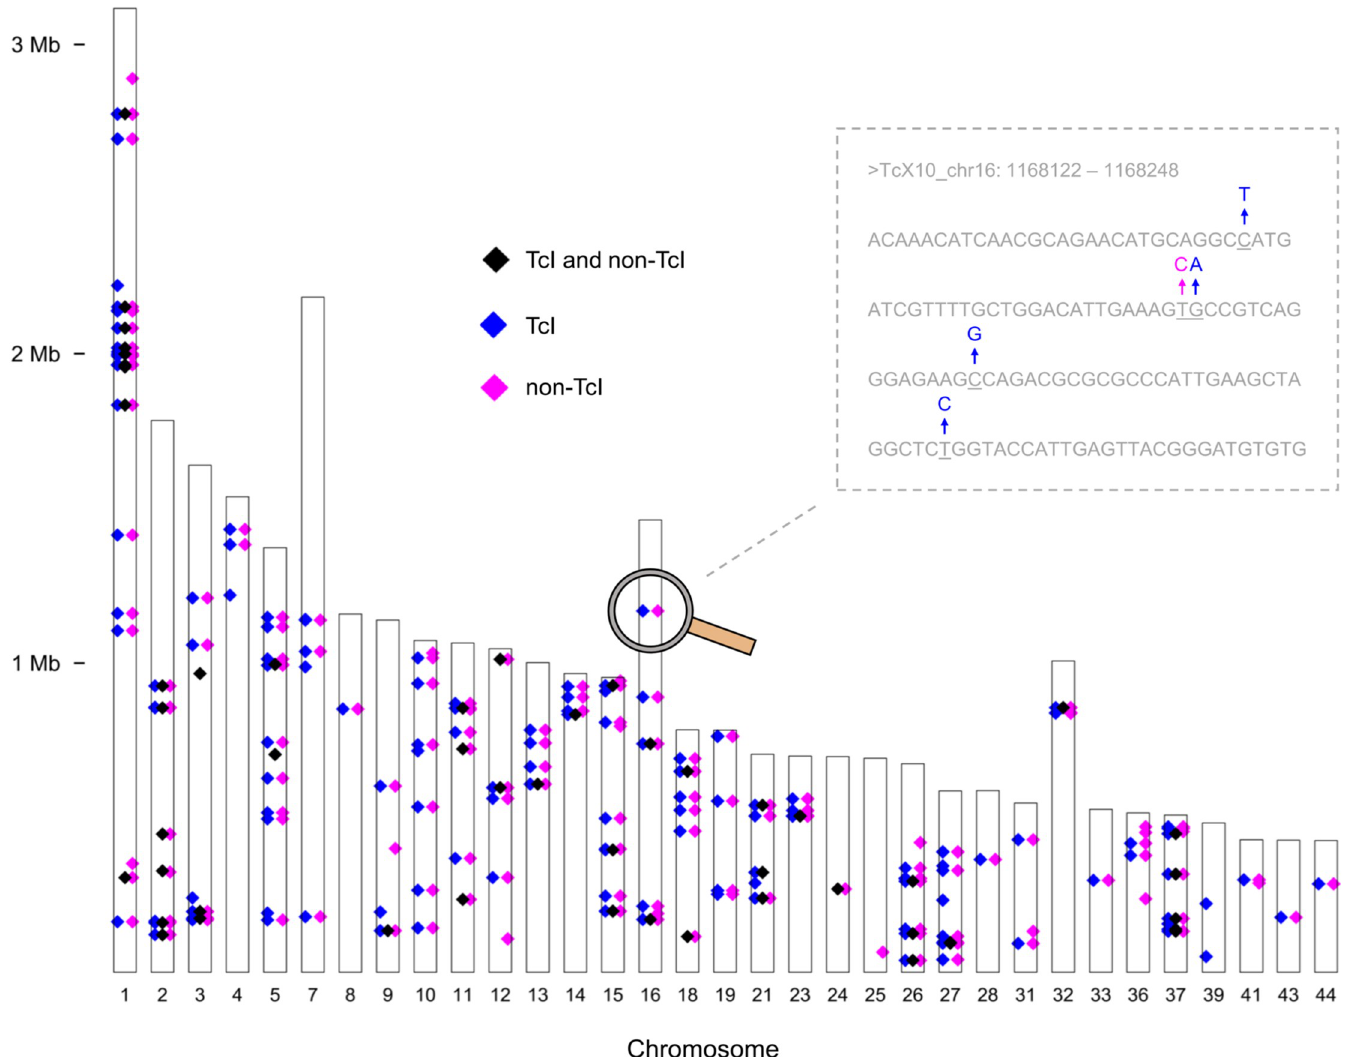
Fig 2. Variant loci detected in T . cruzi I samples and reference clones of other DTUs. The genome-wide distribution of polymorphic segments genotyped using GLST is shown relative to the TcI-Sylvio reference assembly. Blue diamonds represent 303 SNPs detected only in TcI samples and pink diamonds represent 393 SNPs detected only in non-TcI reference clones. Black diamonds represent 84 SNPs detected in both TcI samples and non-TcI reference clones. The close-up illustrates how diamonds representing nearby SNPs (e.g., those occurring on the same GLST target segment) overlap in genome-wide view. Chromosomes 17, 20, 22, 29, 30, 34, 35, 38, 40, 42, 45, 46 and 47 were not targeted by GLST. Chromosome 6 contains one target segment but this segment showed no polymorphism in the sample